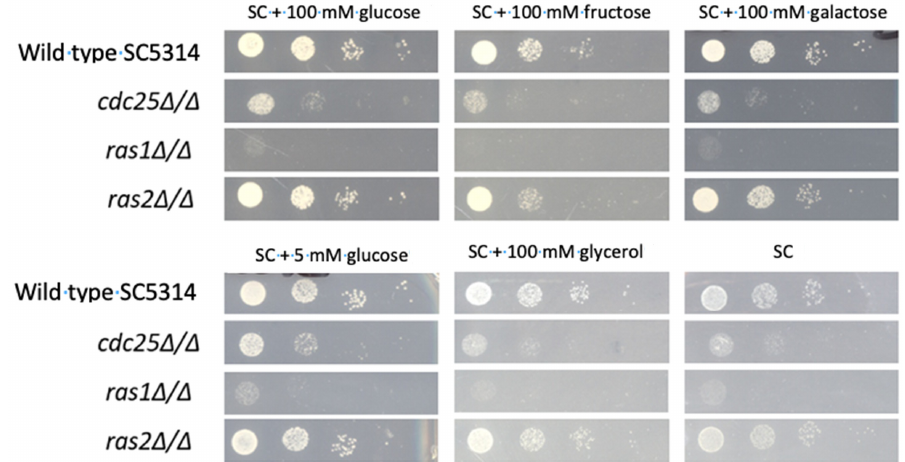
Figure 2. The cdc25 and ras1 mutant show a growth defect on solid medium. The different strains were grown on solid SC medium supplemented with 100 mM glucose, 100 mM fructose, 100 mM galactose, 5 mM glucose, or 100 mM glycerol. The plates were incubated for 24 h at 30 °C before pictures were taken. 3.3. Toxicity of C. albicans Cells towards HeLa Cells Does Not Depend on Cdc25 From literature, it is known that a cdc25 and ras1 deletion strain are not able to fila- ment upon addition of serum which we confirmed with our strains (Figure S1) [19]. Since filamentation is an important factor to inflict damage to host cells, we wanted to check if these mutants had a problem with toxicity towards HeLa cells. It was already shown that a ras1 mutant has a decreased toxicity towards oral epithelial cells. However, since that mutant was obtained in a CAI4 background and we used cervical cells, we also included the ras1 mutant in our study [24, 29]. We showed that a ras1 mutant indeed has a reduced toxicity towards these cells, but a cdc25 mutant showed increased toxicity while it has a defect in filamentation (Figure 3A, Figure S1). This observation was unexpected since it was thought that the effect of Ras1 on cell damaging would work via the PKA pathway. However, if this was the case, a same phenotype should be observed for a cdc25 and ras1 mutant and this was not the case. Furthermore, a ras2 mutant also caused a higher toxicity towards the HeLa cells (Figure 3A).